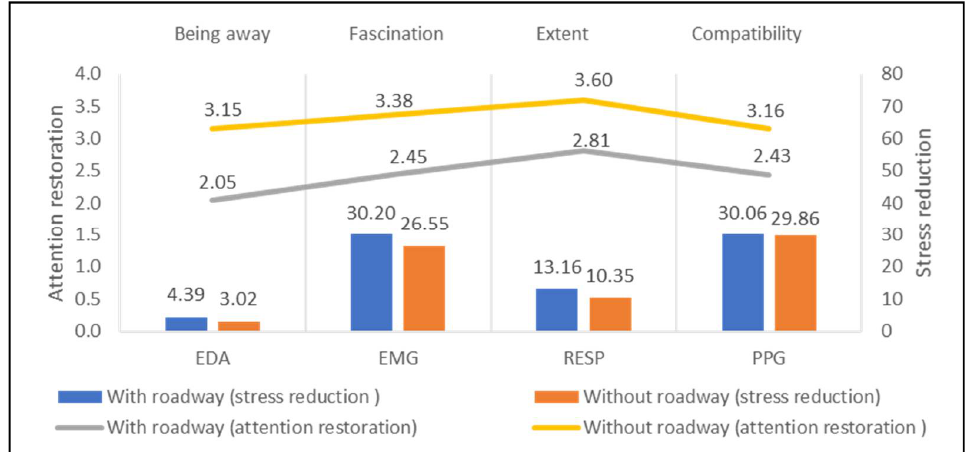
Figure 8. Impacts of the roadway on stress recovery and attention restoration.